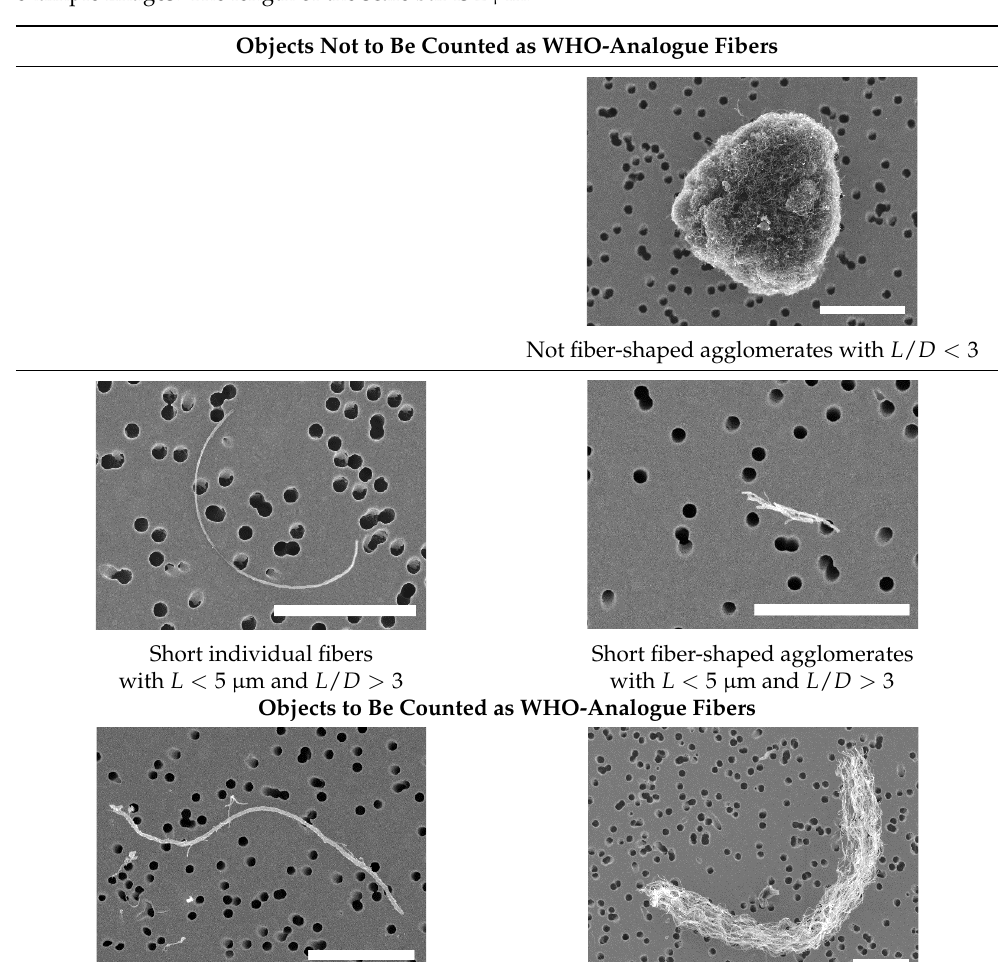
Table 5. Categories for categorizing respirable particles according to morphology, exemplified by example images. The length of the scale bar is 2 µm .